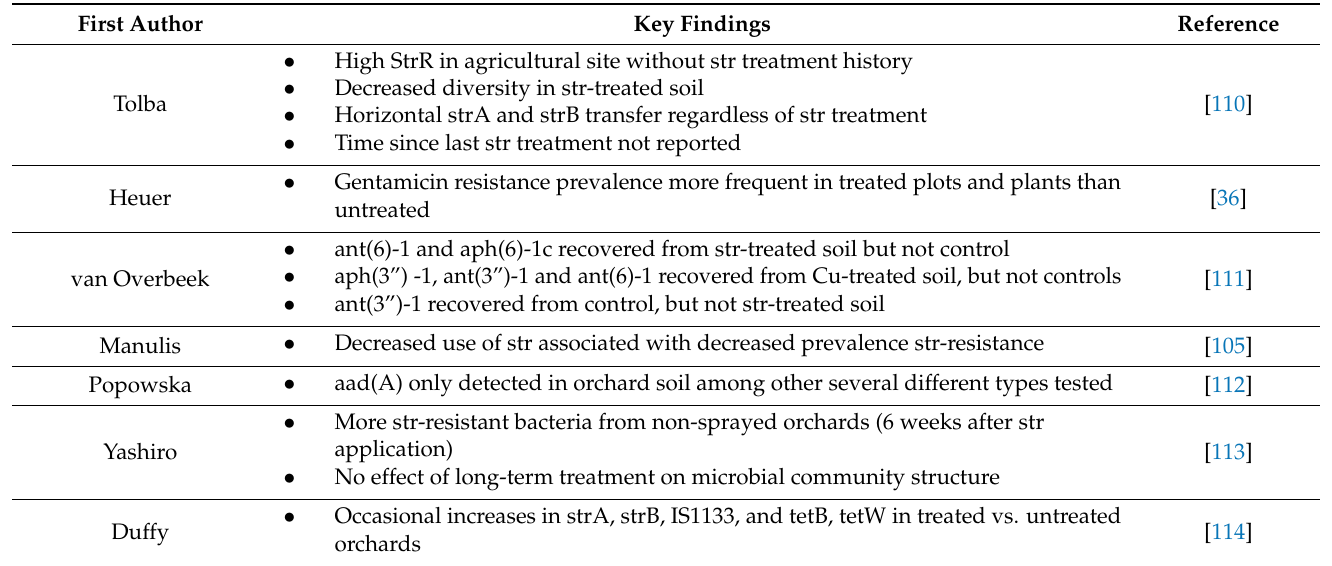
Table 3. Impacts of antimicrobial use in horticulture on antimicrobial